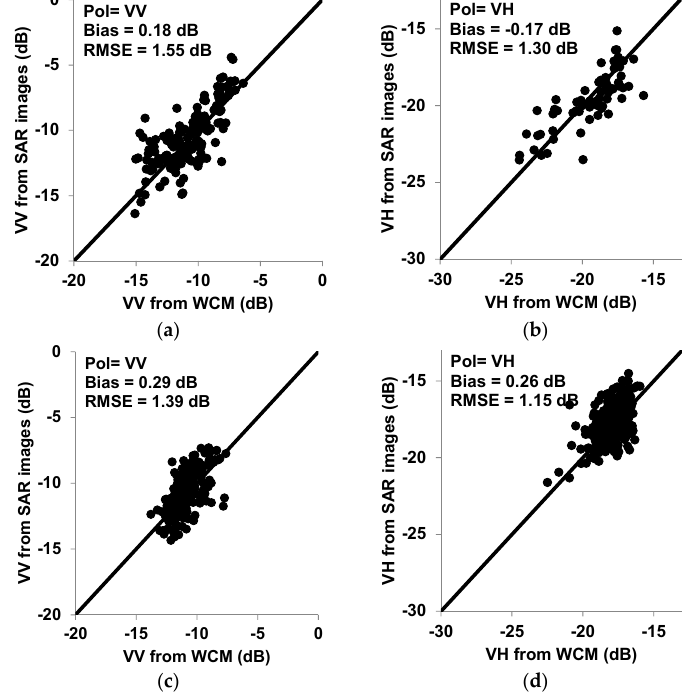
Figure 2. Observed backscattering coefficients from SAR images vs. modeled backscatter values from WCM. Results of the training phase were given in ( a , b ). ( c , d ) correspond to validation phase. Mean of the difference between SAR and WCM and root mean square error were calculated.